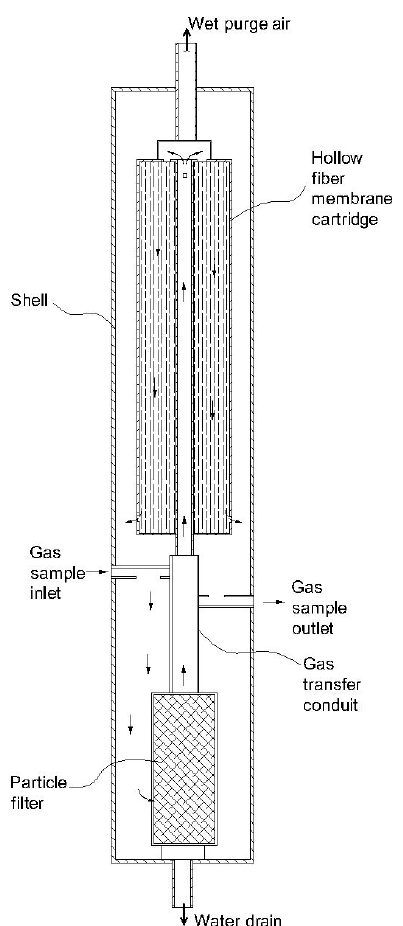
Figure 7. Schematic diagram using a gas dryer coupled with a filtration device [85].